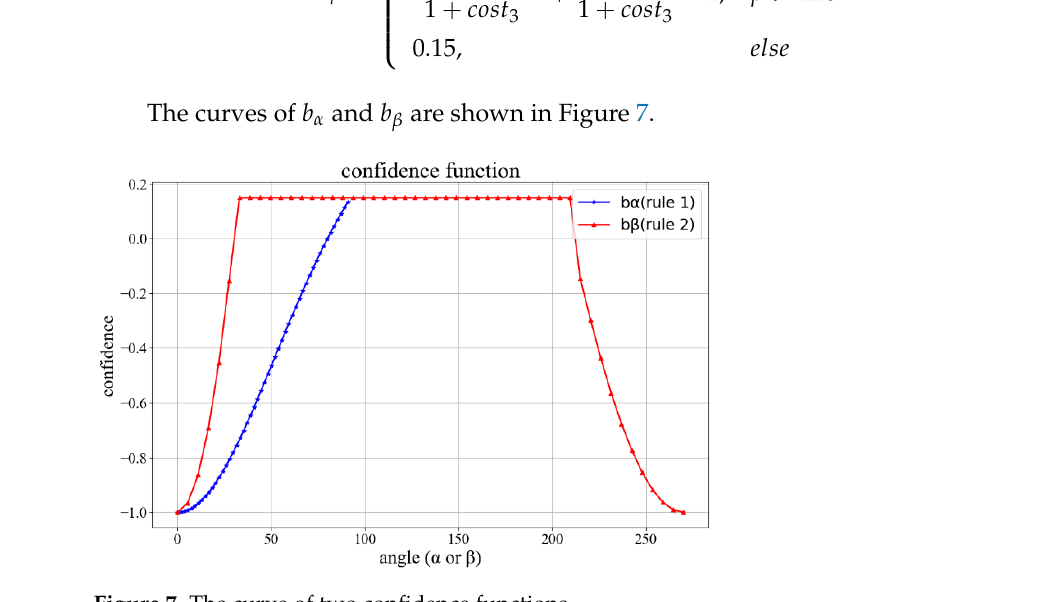
Figure 7. The curve of two confidence functions.